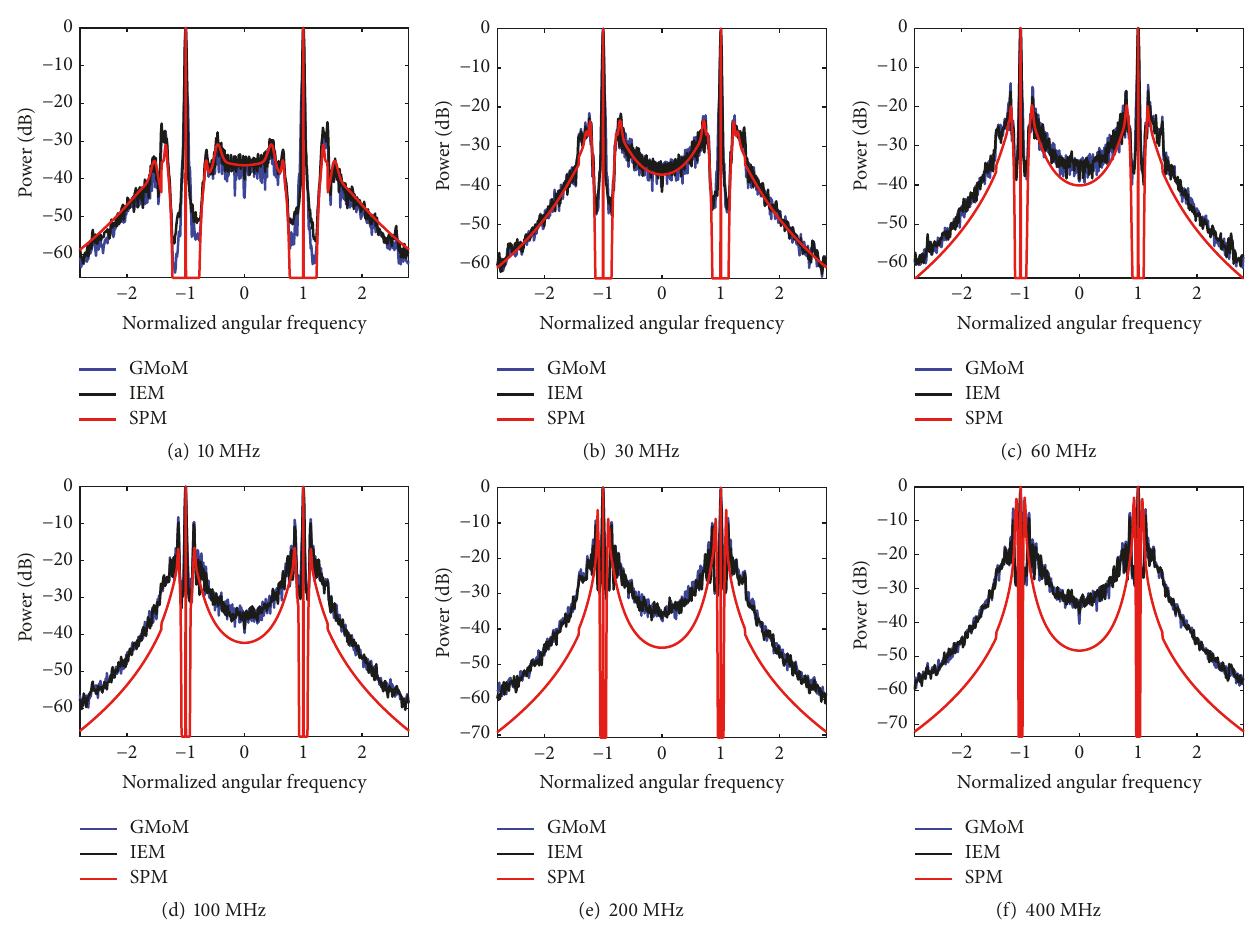
Figure 7: Comparison of Doppler spectrum of linear waves among the proposed method, the classical integral equation method, and the SPM in different frequency bands. The wind speed is 10 m/s, the Doppler frequency is normalized by the Bragg frequency 𝜔 𝑏 , and the spectral intensity is normalized by Bragg